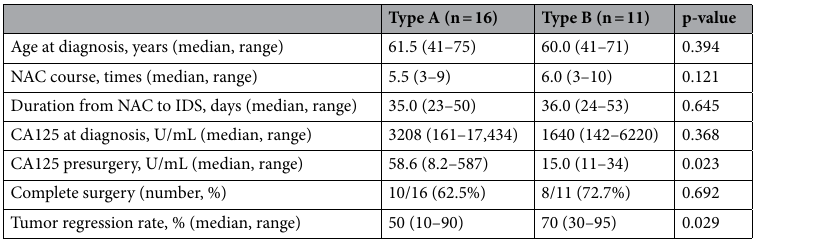
Table 3. Patients characteristics in both groups. NAC neo-adjuvant chemotherapy, IDS interval-debulking